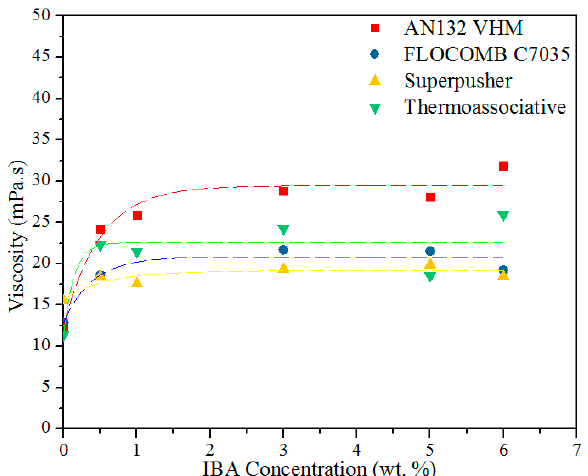
Figure 9. The viscosity of polymers as a function of IBA concentration after 90 days aging time at 80 °C, 5 wt % NaCl, and at 100 s − 1 .